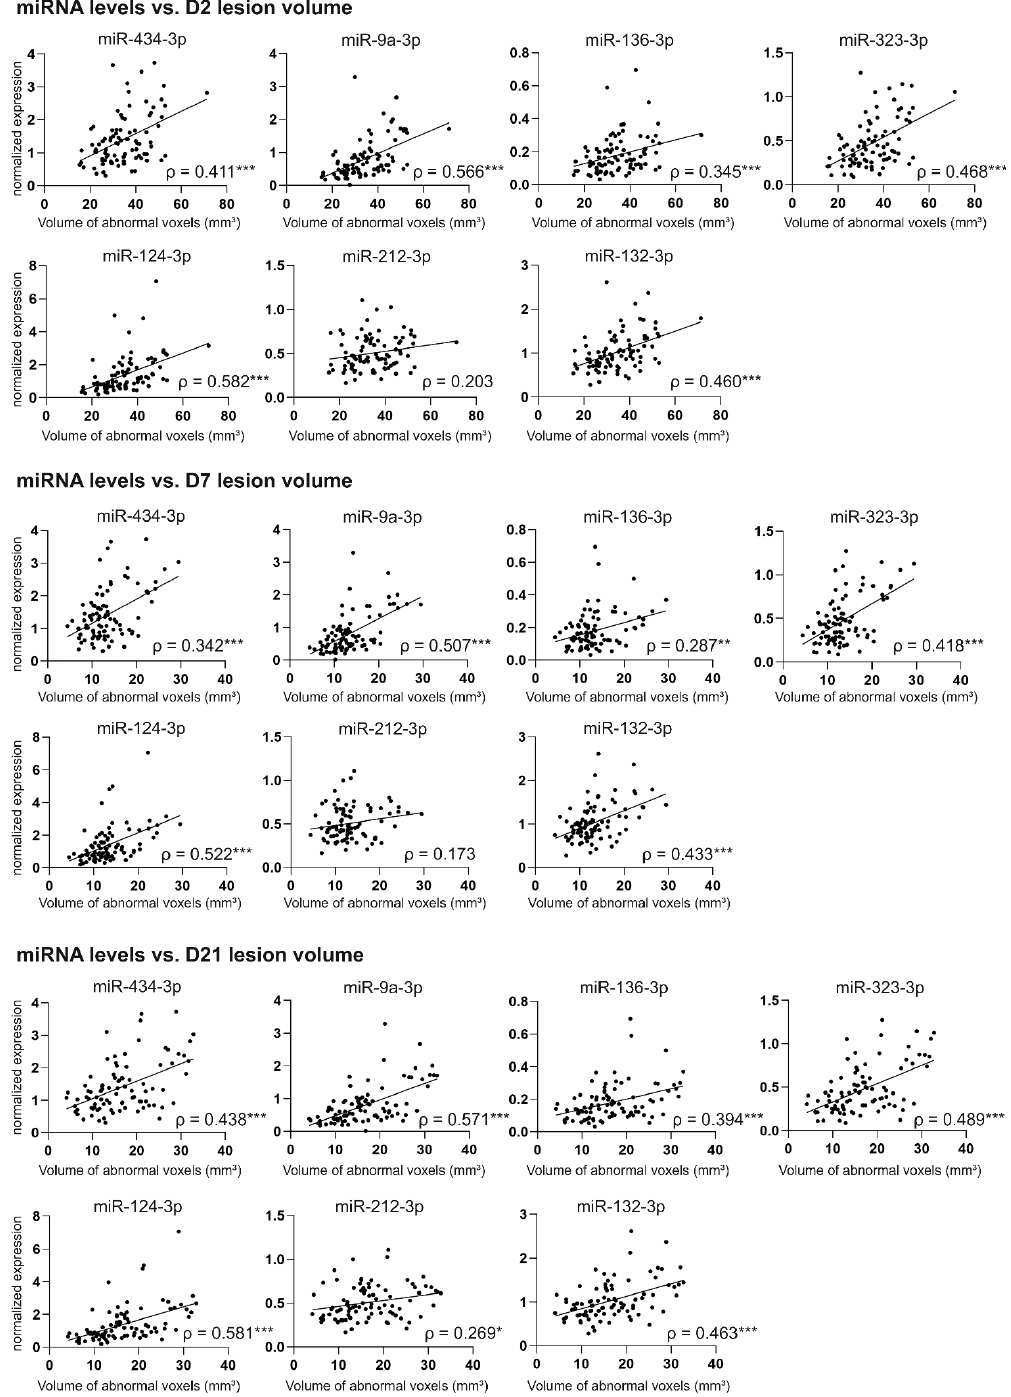
Figure 9. Spearman correlations ( ρ ) between normalized plasma miRNA levels on D2 and cortical lesion severity in quantitative T2 MRI on D2, D7, and D21 after TBI. Each dot represents 1 TBI animal ( n = 89 for D2, n = 90 for D7 and D21). The higher the plasma miRNA levels on D2, the larger the lesion volume in MRI. The total volume of abnormal cortical T2 is shown on the x -axis and the normalized plasma miRNA level is shown on the y-axis. Note that the correlation coefficients were highest on D2 and D21. Statistical significance: *, p < 0.05; **, p < 0.01; ***, p < 0.001 (Spearman correlation). Abbreviations: D2, day 2 after TBI; D7, day 7 after TBI; D21, day 21 after TBI; TBI, traumatic brain